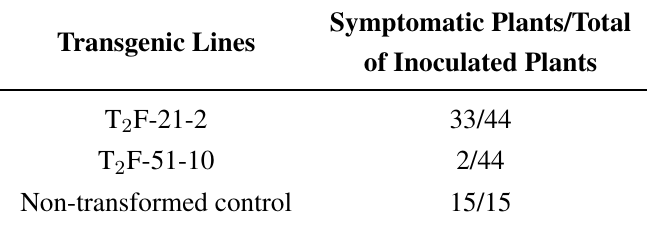
transgenic N. benthamiana plants inoculated with 2